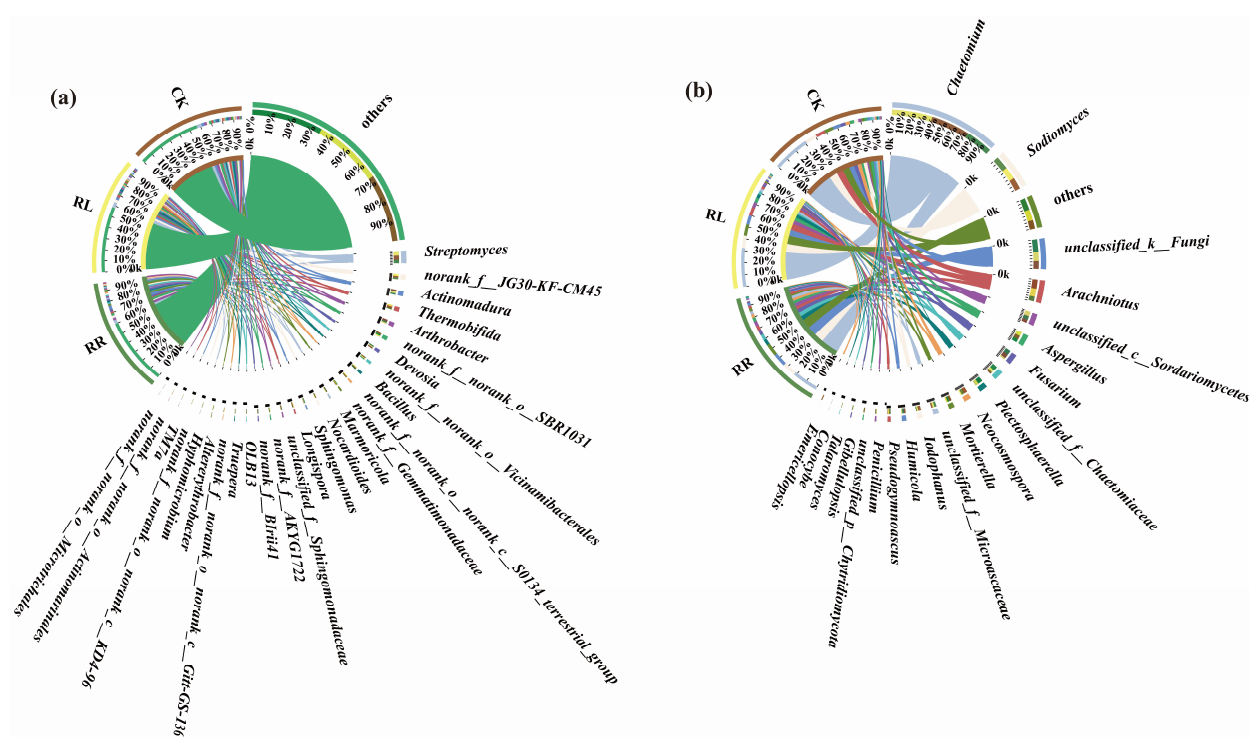
Figure 3. Distribution of the dominant soil bacterial ( a ) and fungal ( b ) phyla in rhizospheres of the oilseed rapes under the RR, RL and CK systems.